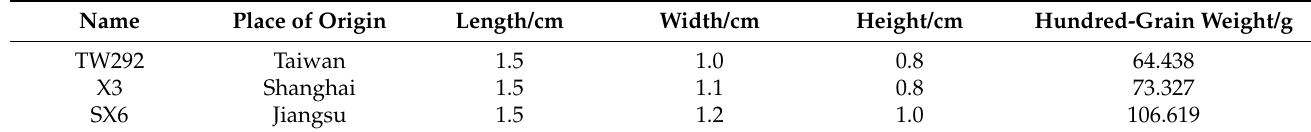
Table 4. Name, geographical origin, and agronomic traits of vegetable soybean samples investigated in this study.